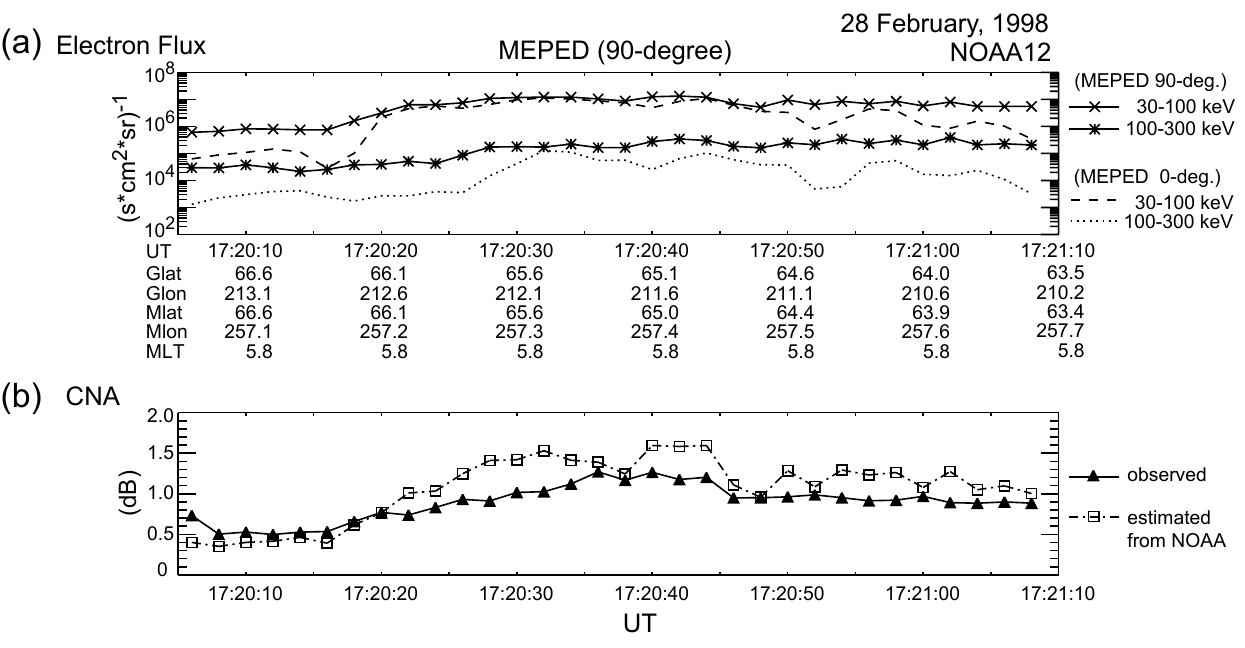
tion is nearly the minimum (maximum) estimate. The CNA